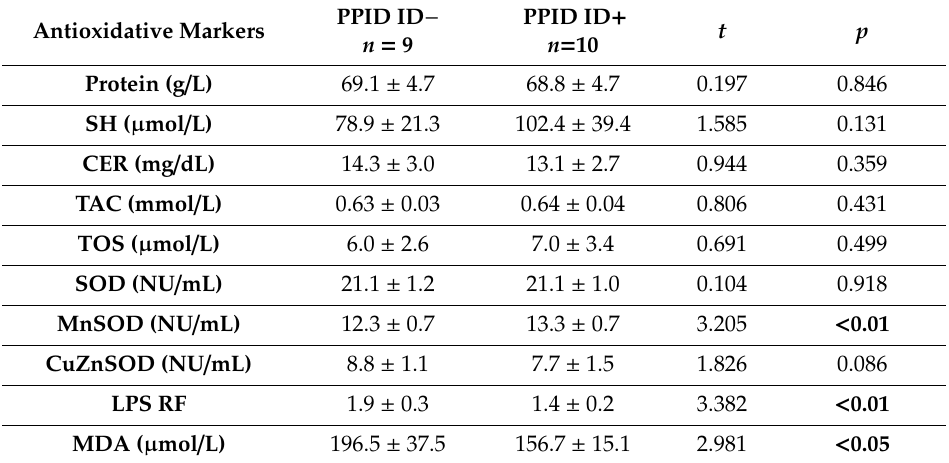
Table 3. The comparisons of antioxidative markers between PPID ID + vs. PPID ID − groups. Antioxidative Markers